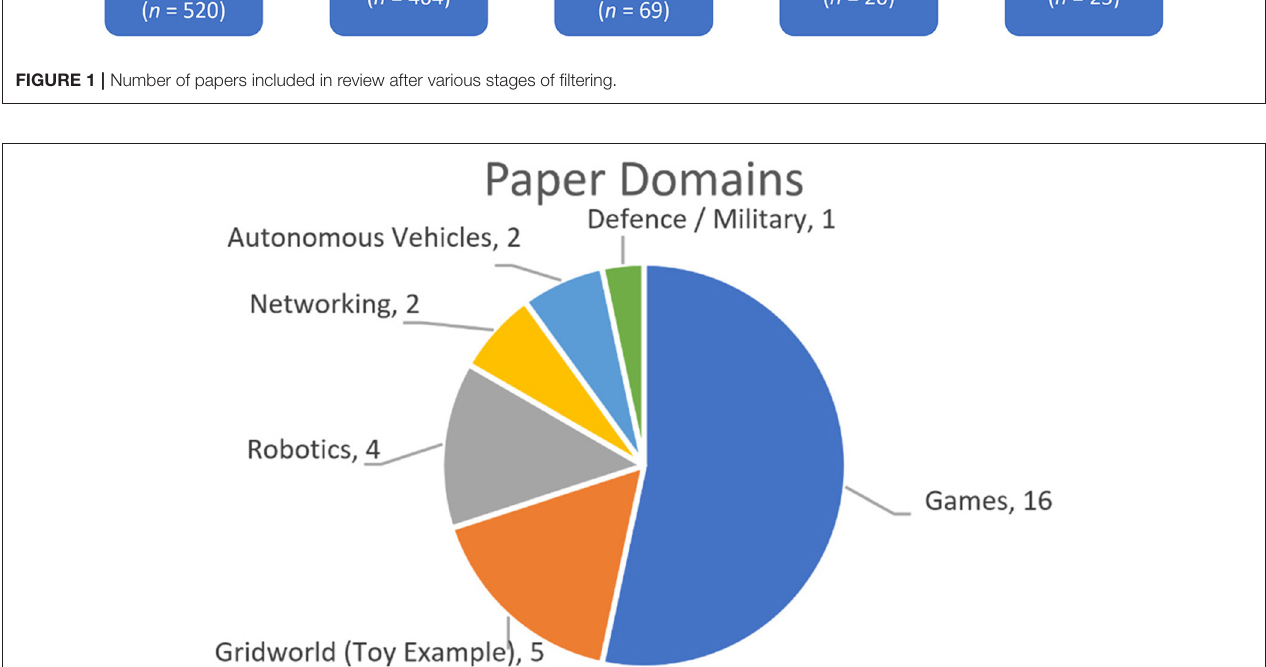
FIGURE 2 | Categorization of papers by domain. Note that some papers were in multiple